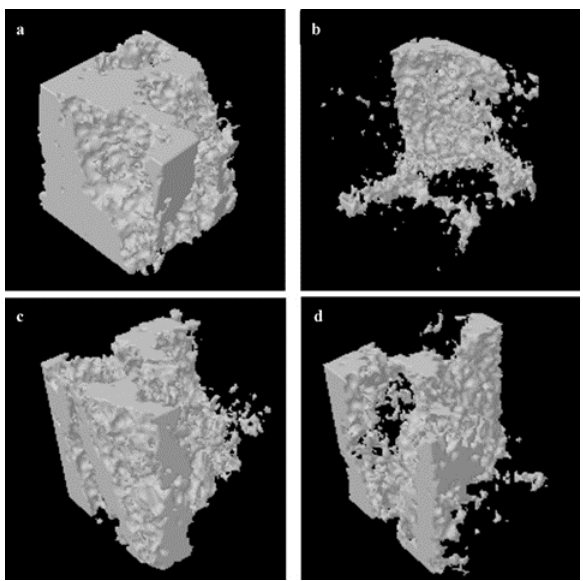
Figure 2. Representative sample from each group: 3-D architecture of alveolar bone beneath the lowest point of first molar crown. ( a ) Sham-operated group (SHAM), ( b ) ovariectomized group (OVX), ( c ) estradiol valerate treatment group (EV), ( d ) Rhizoma Dioscoreae extract treatment group (RDE).